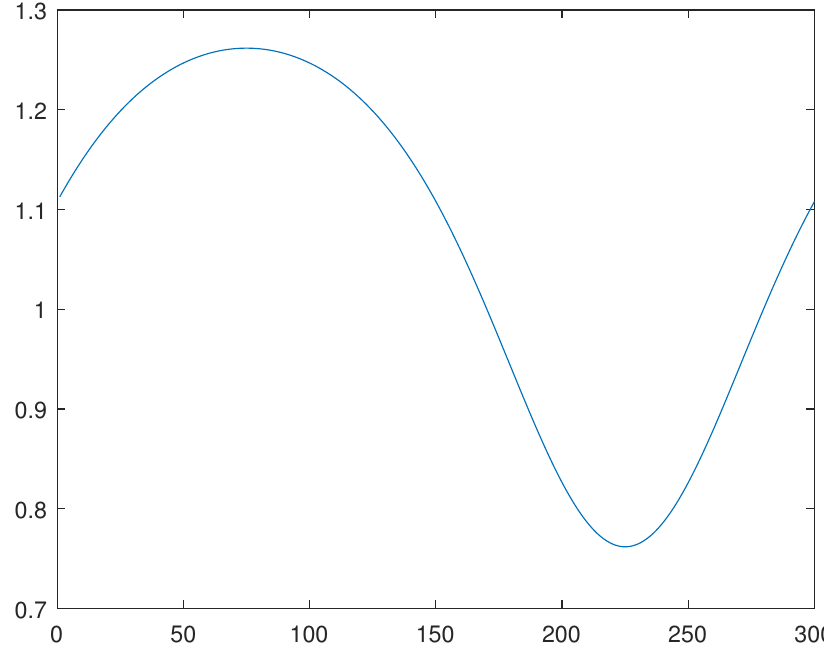
Figure 8. Line 6, solution u 6 ( x ) through Newton’s